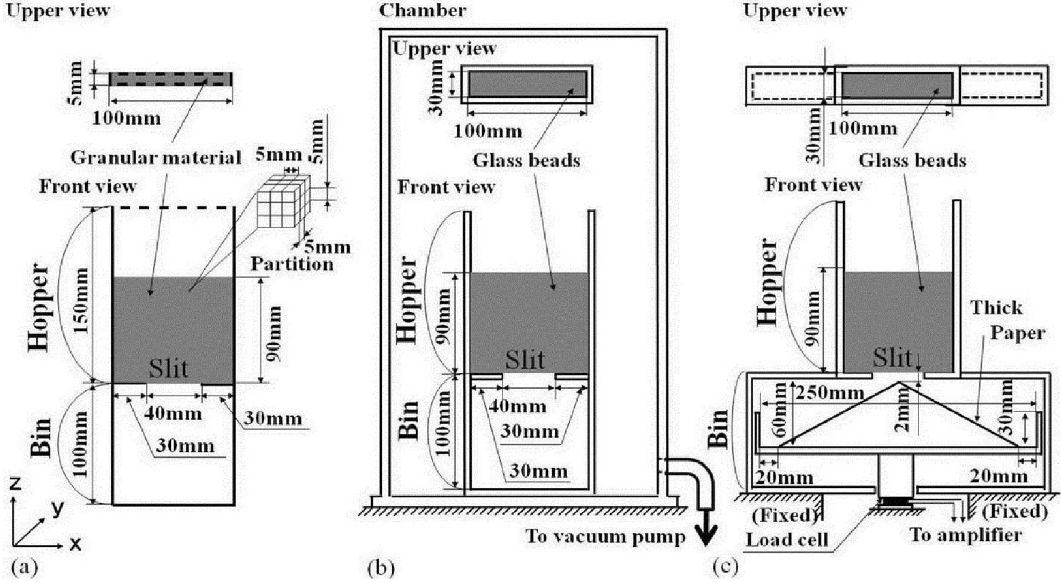
Figure 3. ( a ) Computational domain and boundary conditions; ( b ) Experimental apparatus for snapshot of granular flow; and ( c ) Experimental apparatus for granular flow rate. Bold and dotted lines in (a) show the solid wall boundary conditions (side and bottom walls) and free boundary conditions (top of hopper and front and rear walls of hopper and